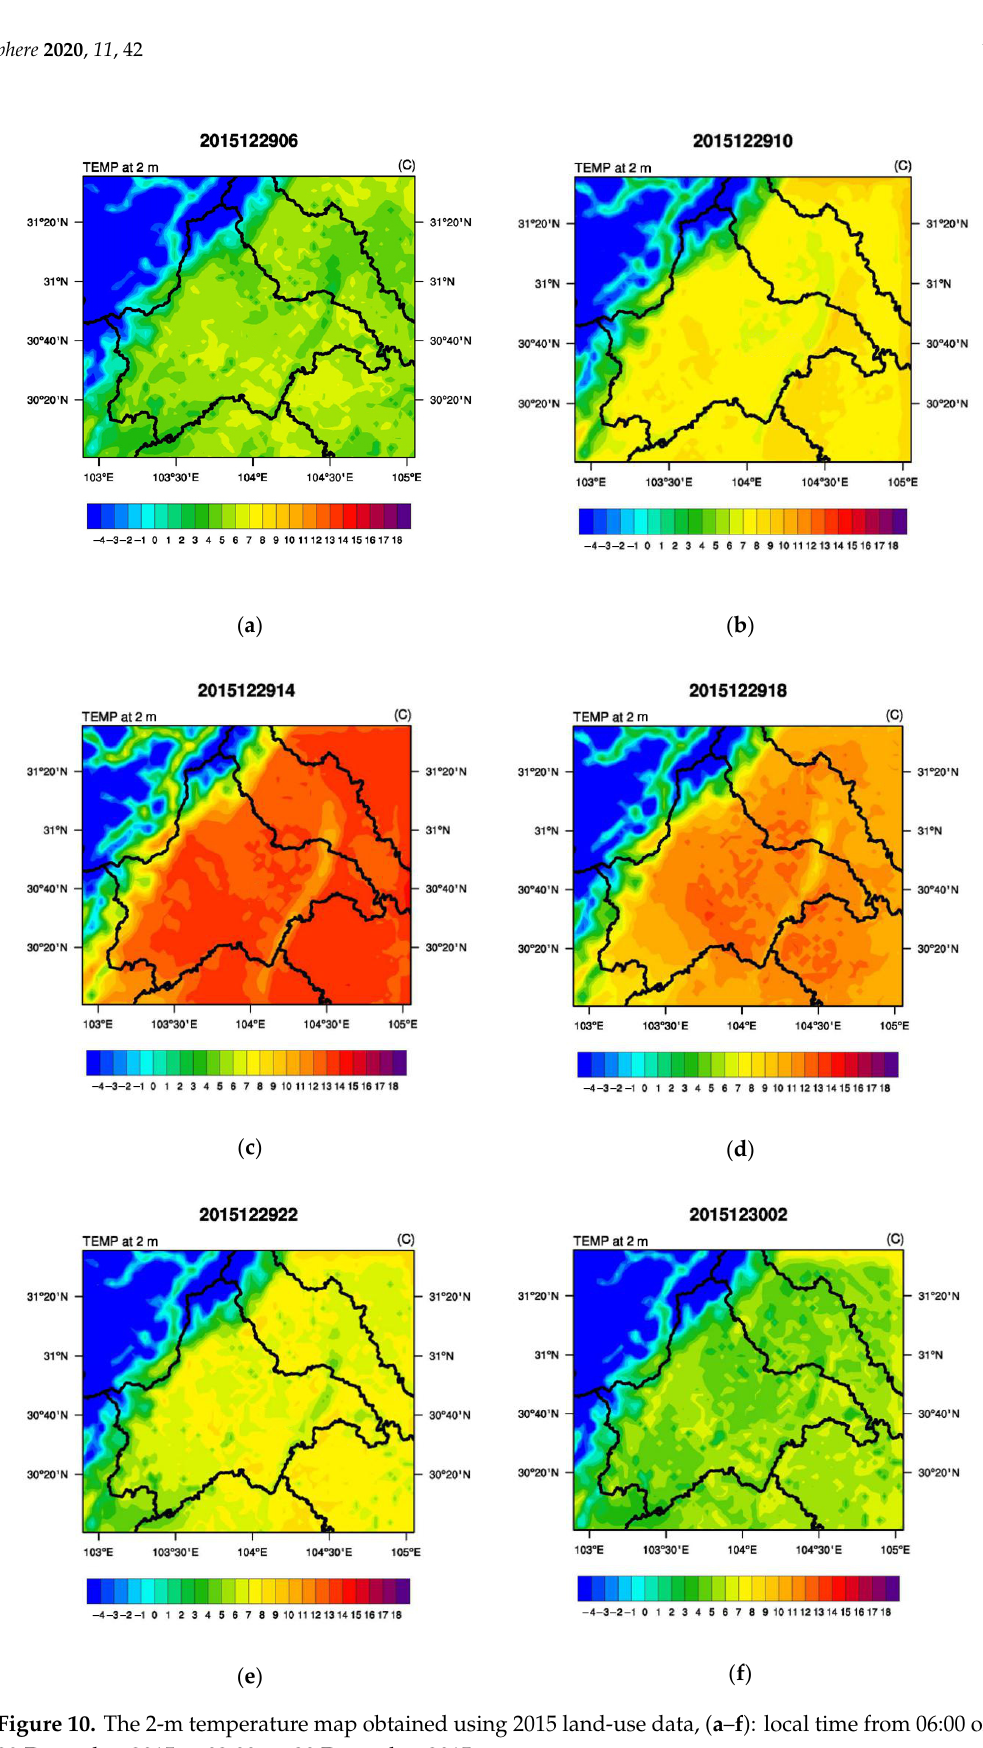
Figure 10. The 2-m temperature map obtained using 2015 land-use data, ( a – f ): local time from 06:00 on 29 December 2015 to 02:00 on 30 December